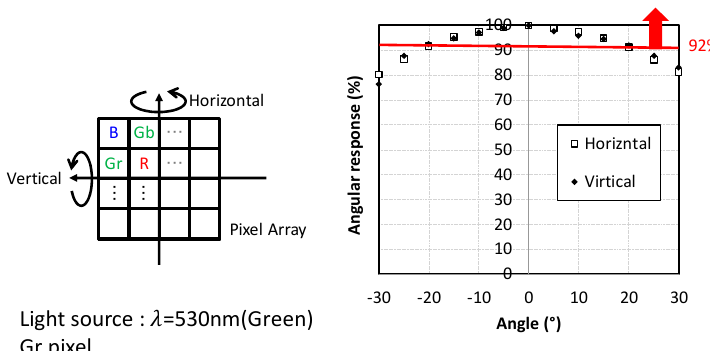
Figure 10. Angular response (AR) of Gr pixels. A 530 nm light source is used and the output levels of measured pixels are around one half the saturation level.